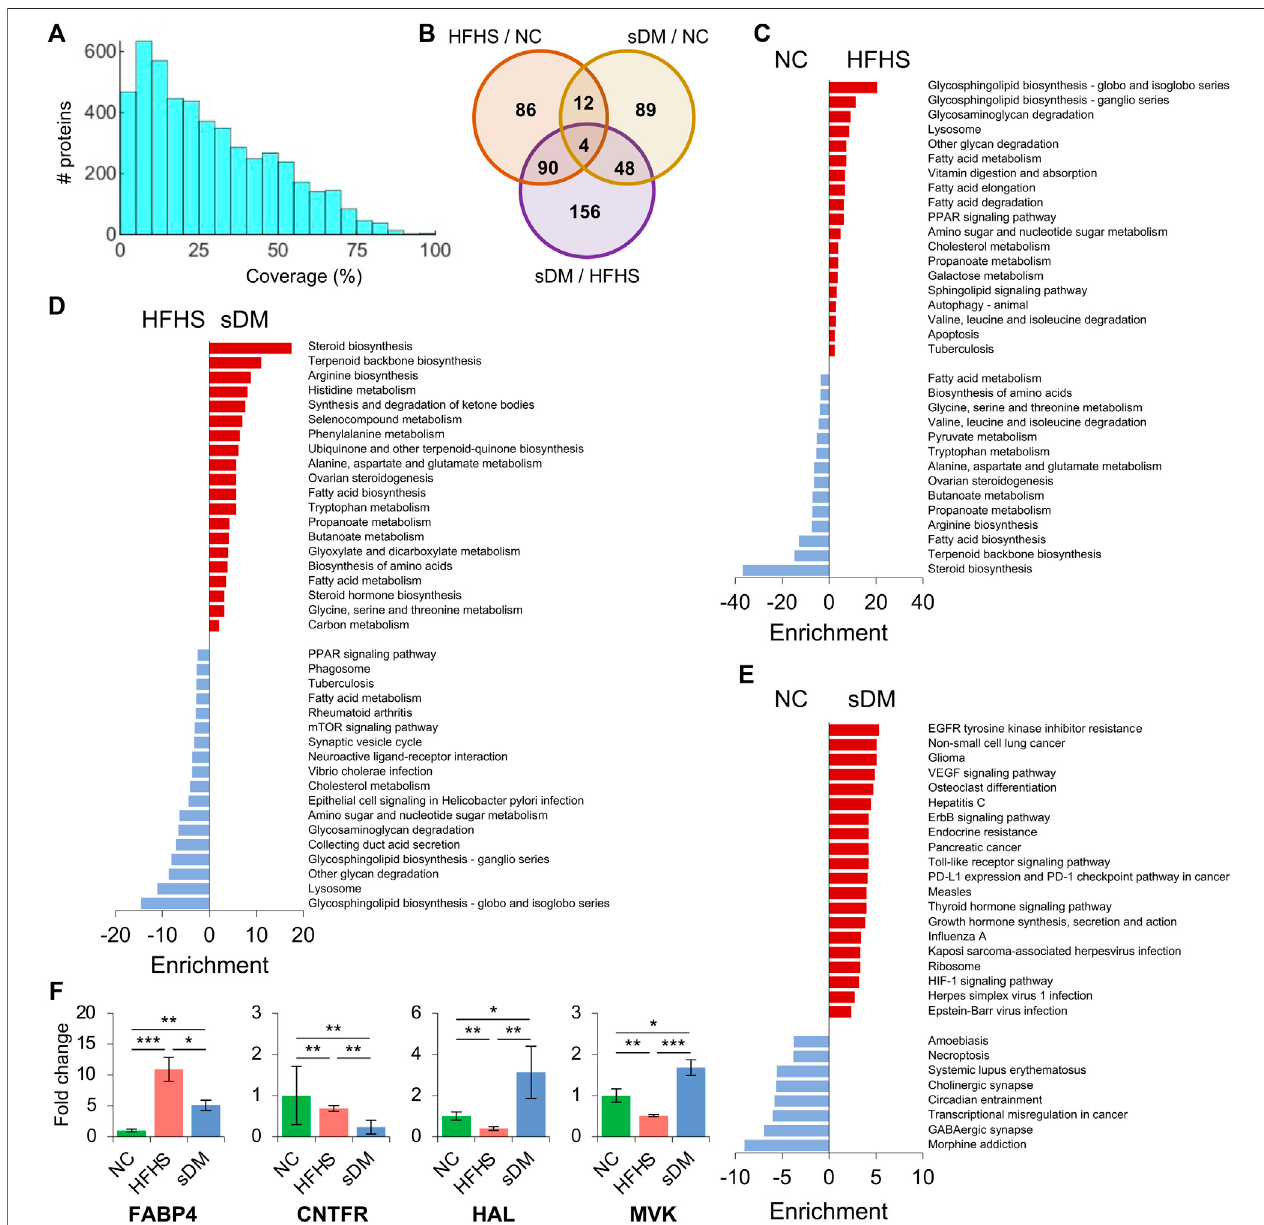
FIGURE 4 | Proteomic pro fi ling in the liver of the three groups. (A) The histogram of sequence coverage of all identi fi ed proteins. (B) The numbers of signi fi cantly changed proteins between the groups. (C – E) KEGG pathway enrichment of the altered proteins between the NC and HFHS groups (C) , between the sDM and HFHS groups (D) ,andbetweenthesDMandNCgroups (E) . (F) Thefoldchangesofthefourdifferentiallyexpressedproteinsamongallthreegroups.FABP4;Fattyacidbinding protein4;CNTFR,Ciliaryneurotrophicfactorreceptor;HAL,Histidineammonia-lyase;MVK,Mevalonatekinase.Mean ± SDareshown.*, p < 0.05;**, p < 0.01;***, p <